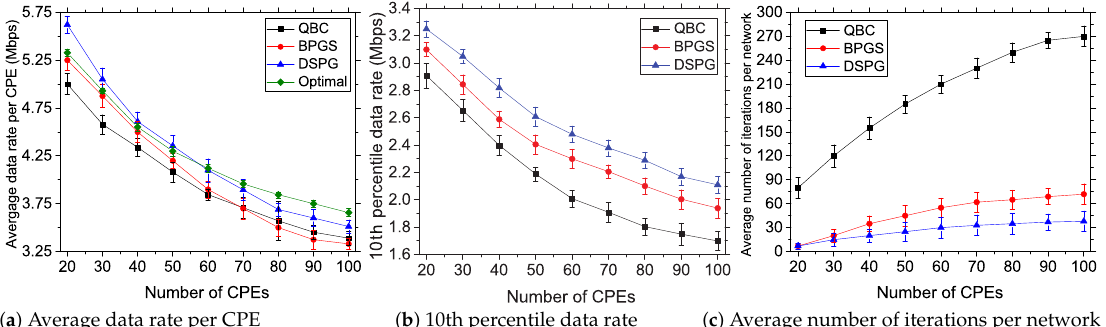
Figure 6. Impact of CPE density on the performance of the studied resource allocation